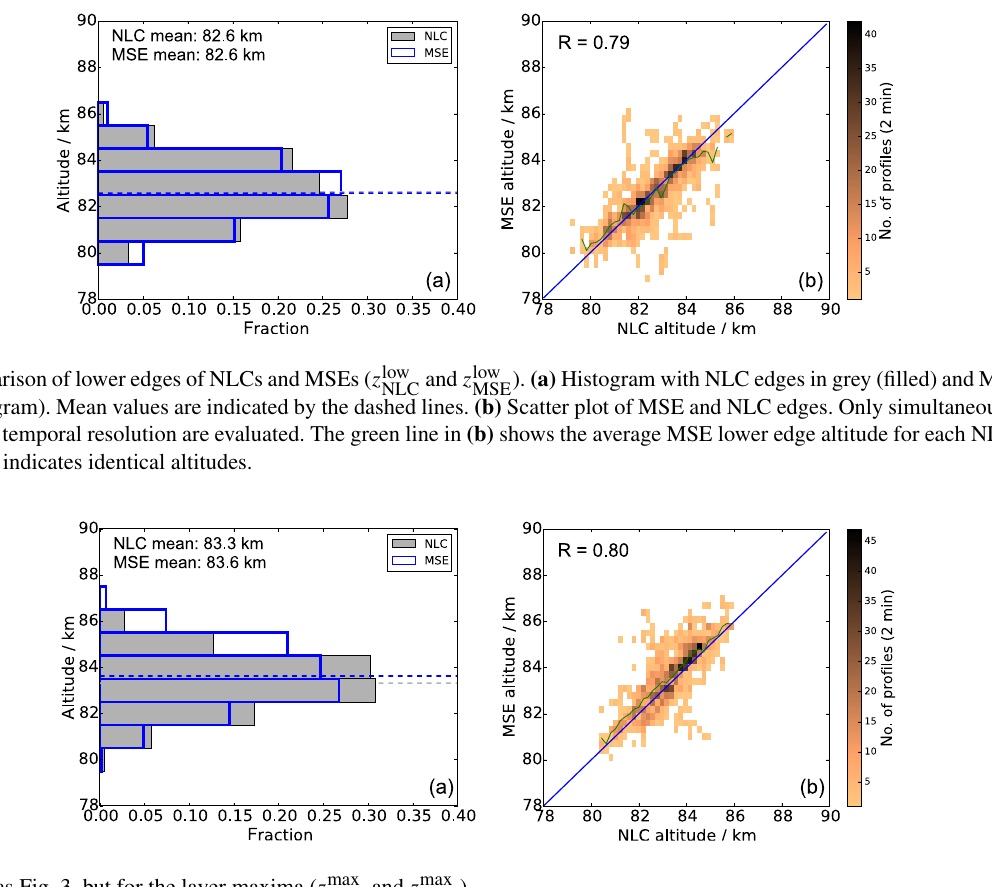
and z max NLC MSE